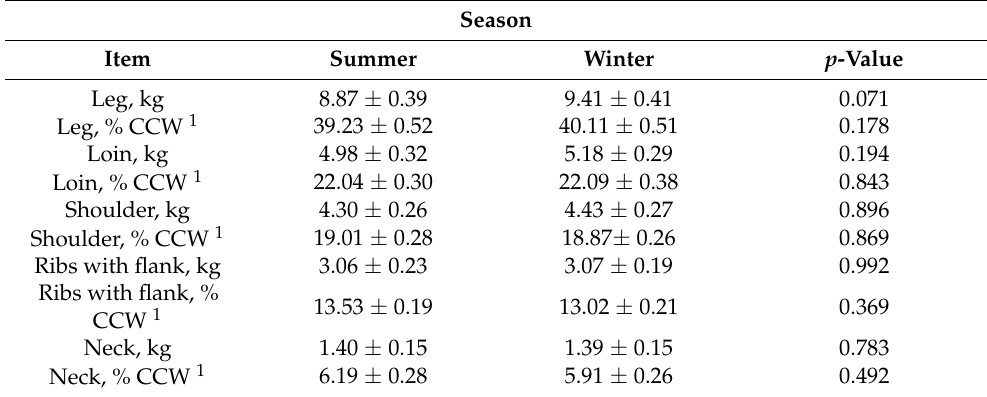
Table 3. Seasonal variation in the proportion of carcass parts in the cold carcass weight (LSM ± SE). Season